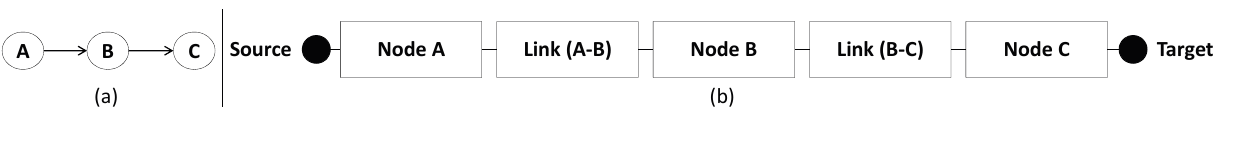
Figure 8. Example of a ( a ) WSN path and ( b ) its RBD